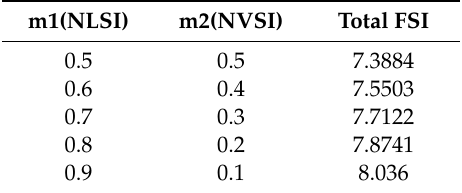
Table 2. A contrast of FSI of the system for various